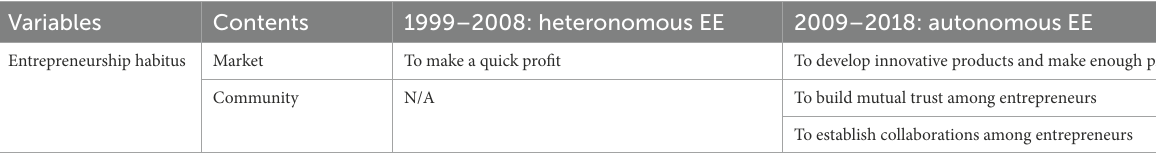
TABLE 2 Entrepreneurship habitus components from Shenzhen entrepreneurs’